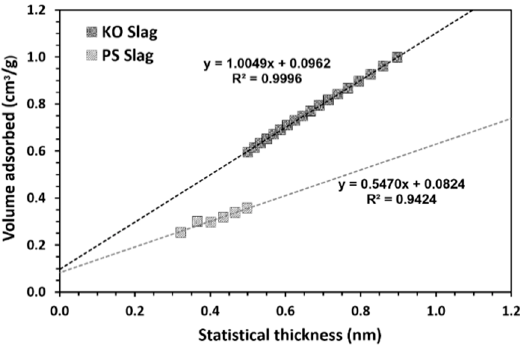
Figure 2. T-plot of inorganic polymers (IPs) precursors used: KO and PS slags.